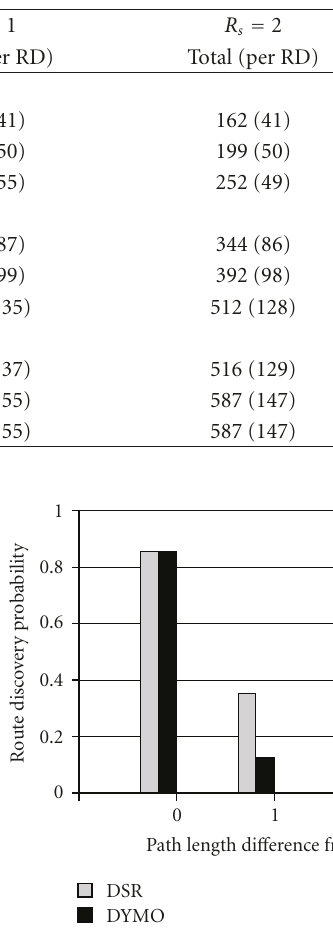
Table 3: Routing overhead of DYMO under mobility.